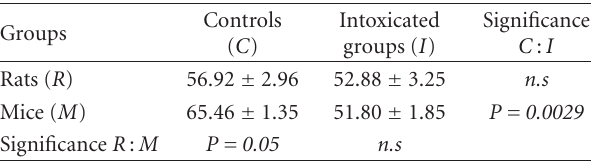
Table 2: GSH concentration ( µ mol/g of the tissue) in the groups of intoxicated rats and mice and in the control groups.